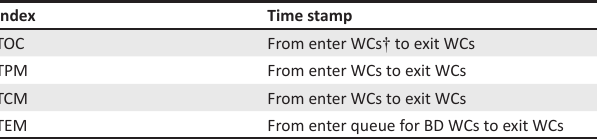
TABLE 4: Time stamp for each index.